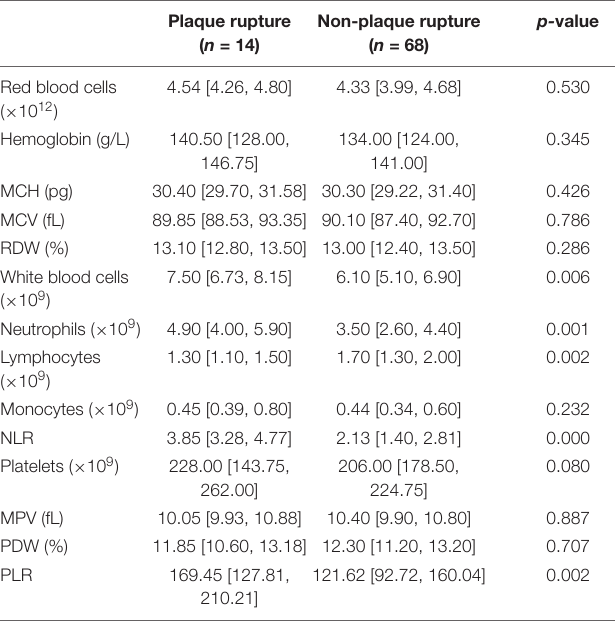
TABLE 2 | Hematological indices of patients with or without plaque rupture. Plaque rupture ( n = 14)